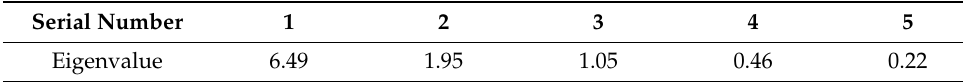
Table 2. Five largest eigenvalues.